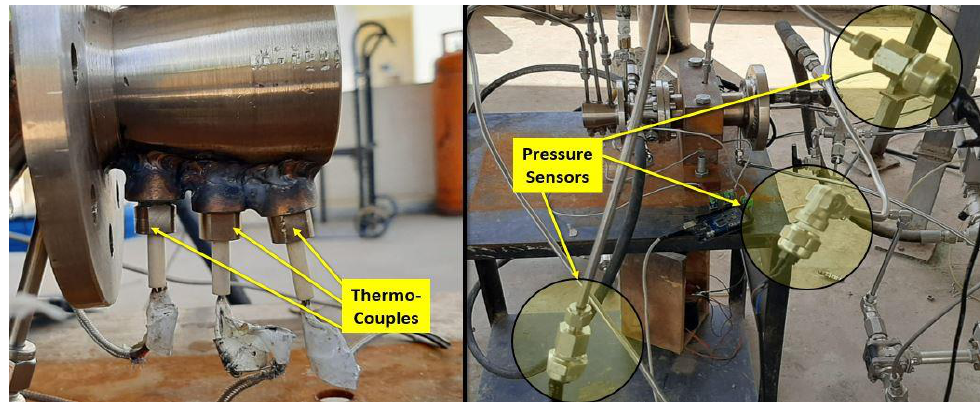
Figure 16. Thermocouples and pressure sensors.